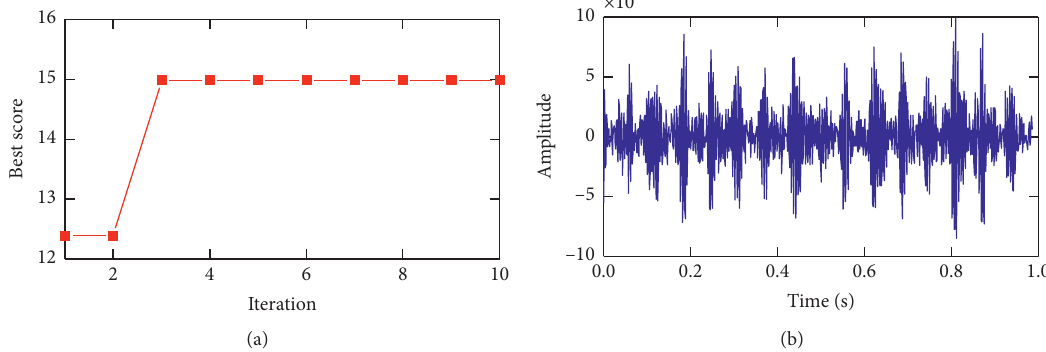
Figure 8: Case1: (a) fitness convergence curve for PPCA optimization; (b) time-domain diagram after noise reduction by